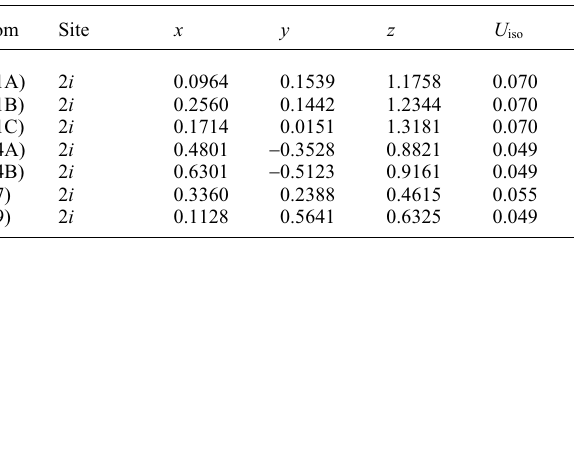
Table 2. Atomic coordinates and displacement parameters (in Å 2 ) .